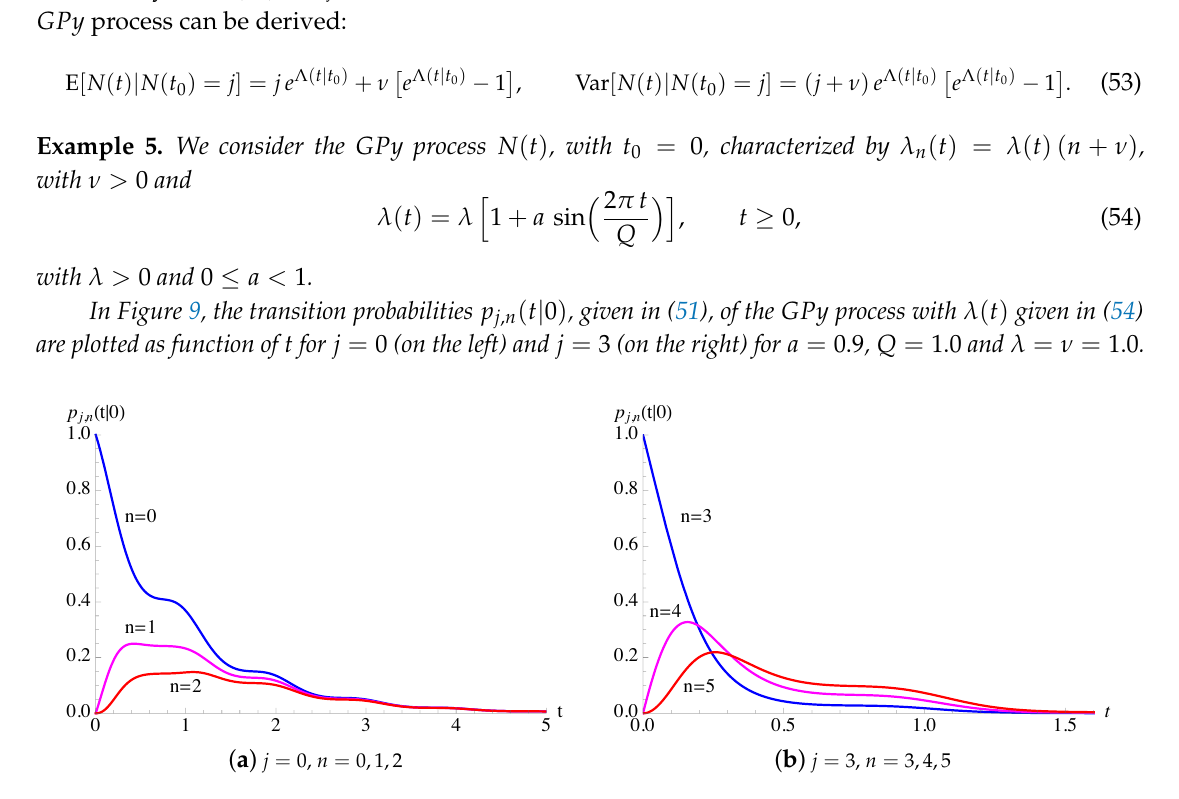
Figure 9. For the generalized Polya ( GPy ) process, having λ n ( t ) = λ ( t ) ( n + ν ) , with λ ( t ) given in (54), the probabilities p j , n ( t | 0 ) are plotted as function of t for a = 0.9, Q = 1.0 and λ = ν = 1.0. In Figure 10, the conditional mean and the conditional variance, given in (53), of the GPy process of Figure 9 are plotted as function of t for j = 0 , λ = 1.0 , a = 0.9 , Q = 1.0 and some choices of ν